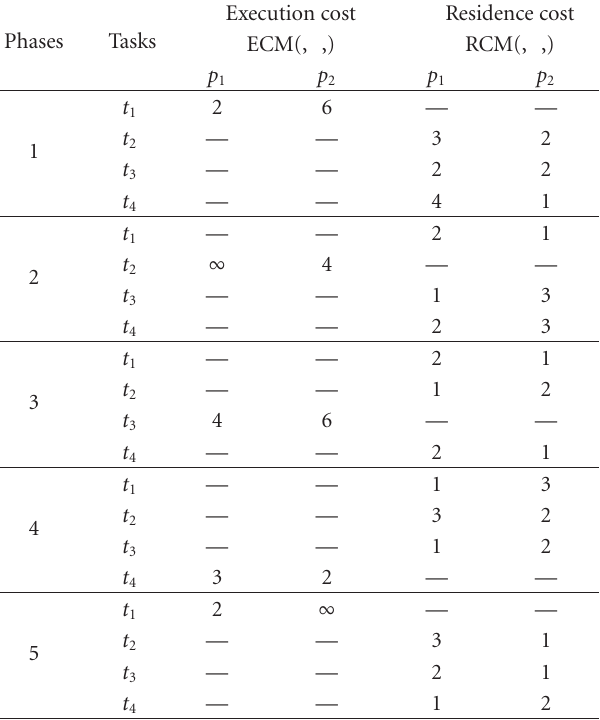
Table 1: Phasewise ECM(, ,) and RCM(, ,). Phases